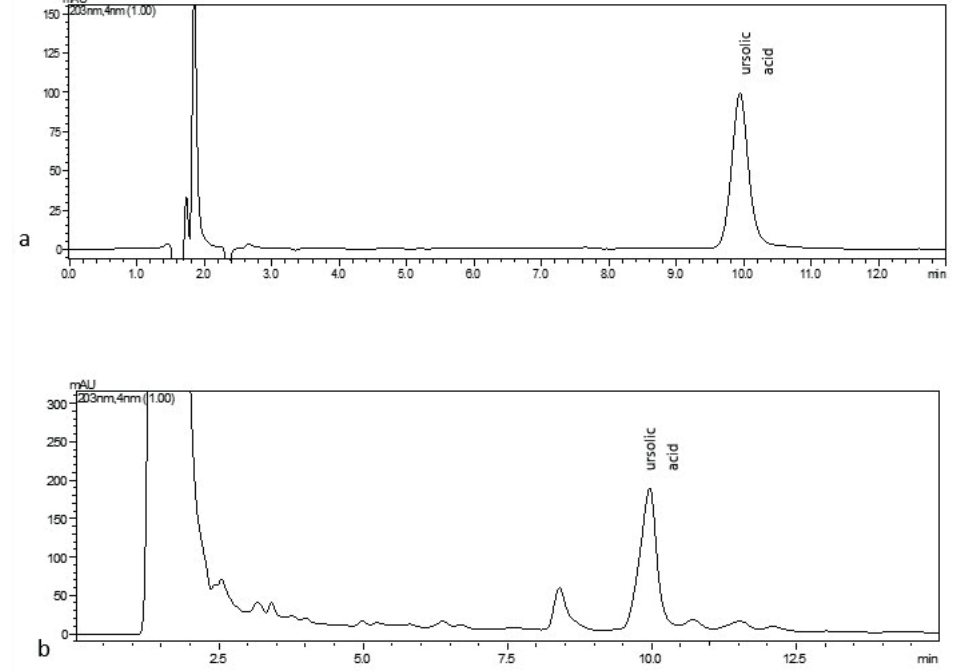
Figure 1 - Chromatogram obtained by HPlC-DAD for the UA standard ( a ); chromatogram of the methanol extract of the leaves of S. australis Cham. & Schltdl obtained by HPlC-DAD ( b ). Wavelength was 203 nm. Retention time was 9.94 min for